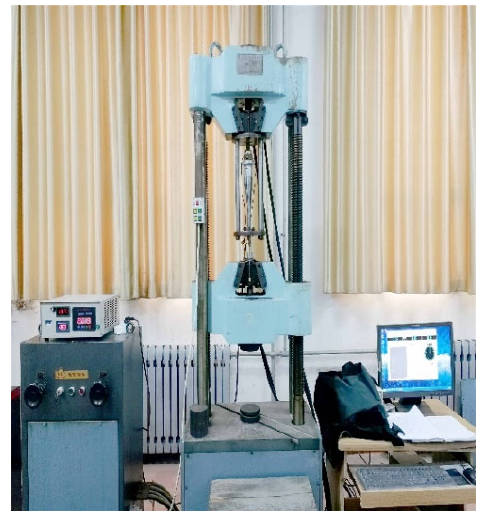
Figure 13. Schematic of the ultrasonic vibration tensile device. Materials 2019 , 12 , 3841 10 of 15